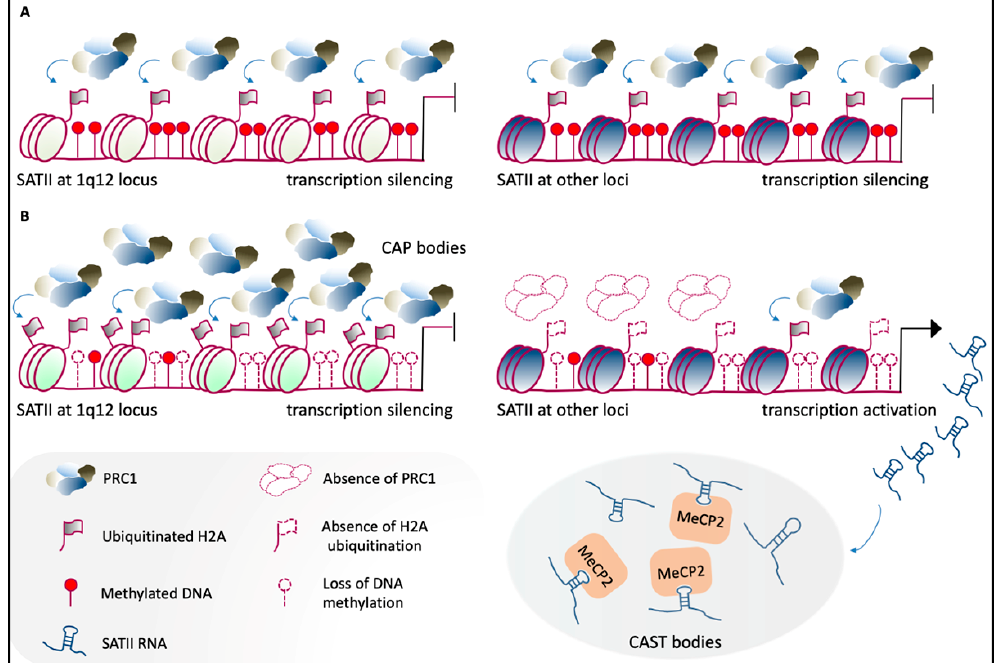
Figure 4. Human PCH organization in health and disease. ( A ) Under normal physiological conditions, satellite II (SATII) at the 1q12 locus (left) and at other chromosomal loci (right) is highly methylated at the DNA level and binds the PRC1 complex, which mediates H2A ubiquitination. This molecular landscape leads to the maintenance of the transcriptionally inactive state [151]. ( B ) In cancer cells, the loss of methylation across SATII loci causes hyper-accumulation of PRC1 proteins at SATII at the 1q12 locus, which leads to the formation of cancer-associated polycomb (CAP) bodies (top-left). This mechanism maintains the silencing of 1q12-SATII, which is reinforced by increased H2A ubiquitination. At other loci, SATII shows less accumulation of ubiquitinated H2A, and becomes transcriptionally active (top right). This leads to the formation of cancer-associated satellite transcript (CAST) bodies, in which there is an aberrant accumulation of SATII RNAs. These aggregates sequester epigenetic factors, including MeCP2. Adapted from [151].